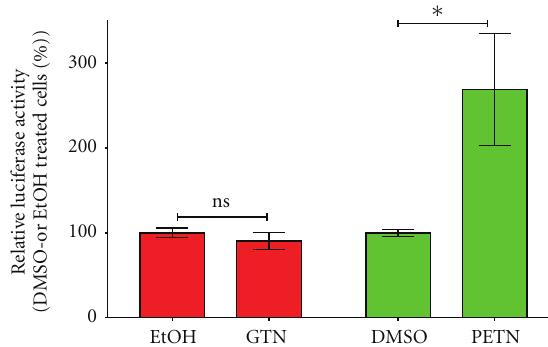
Figure 8: Post-transcriptional regulation of the human HO-1 expression. Human endothelial EA.hy 926cells were transiently transfected with pGL3-Control-HO-1-3-UTR and pRenilla (normalization of transfection e ffi ciency). After 24h the cells were treated with 50 μ M nitroglycerin (GTN) or PETN (or the solvents ethanol [EtOH] or DMSO) for 6h. Extracts were prepared and luciferase and Renilla activity were determined. The luciferase activity was normalized to the renilla activity. Shown (mean ± SEM; n = 6–8) are the normalized luciferase activity values. The normalized luciferase activity of the cell treated with solvent were set to 100% ( ∗ = P < 0 . 05; ns = not significant versus EtOH- or. DMSO treated